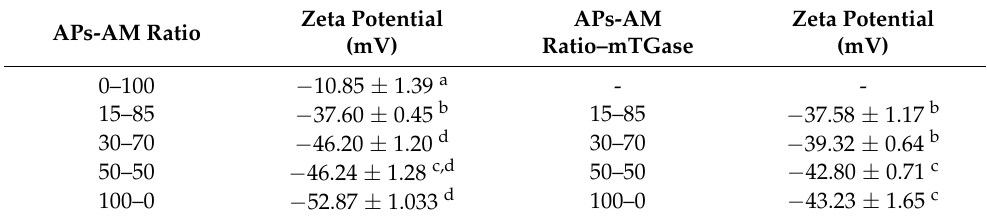
Table 1. Zeta Potential analysis of FFSs at different ratios APs-AM (0–100, 15–85, 30–70, 50–50, 100–0% ( w/w )). Different small letters (a–d) indicate significant differences among the values reported in the columns ( p < 0.05). The analysis was carried out in